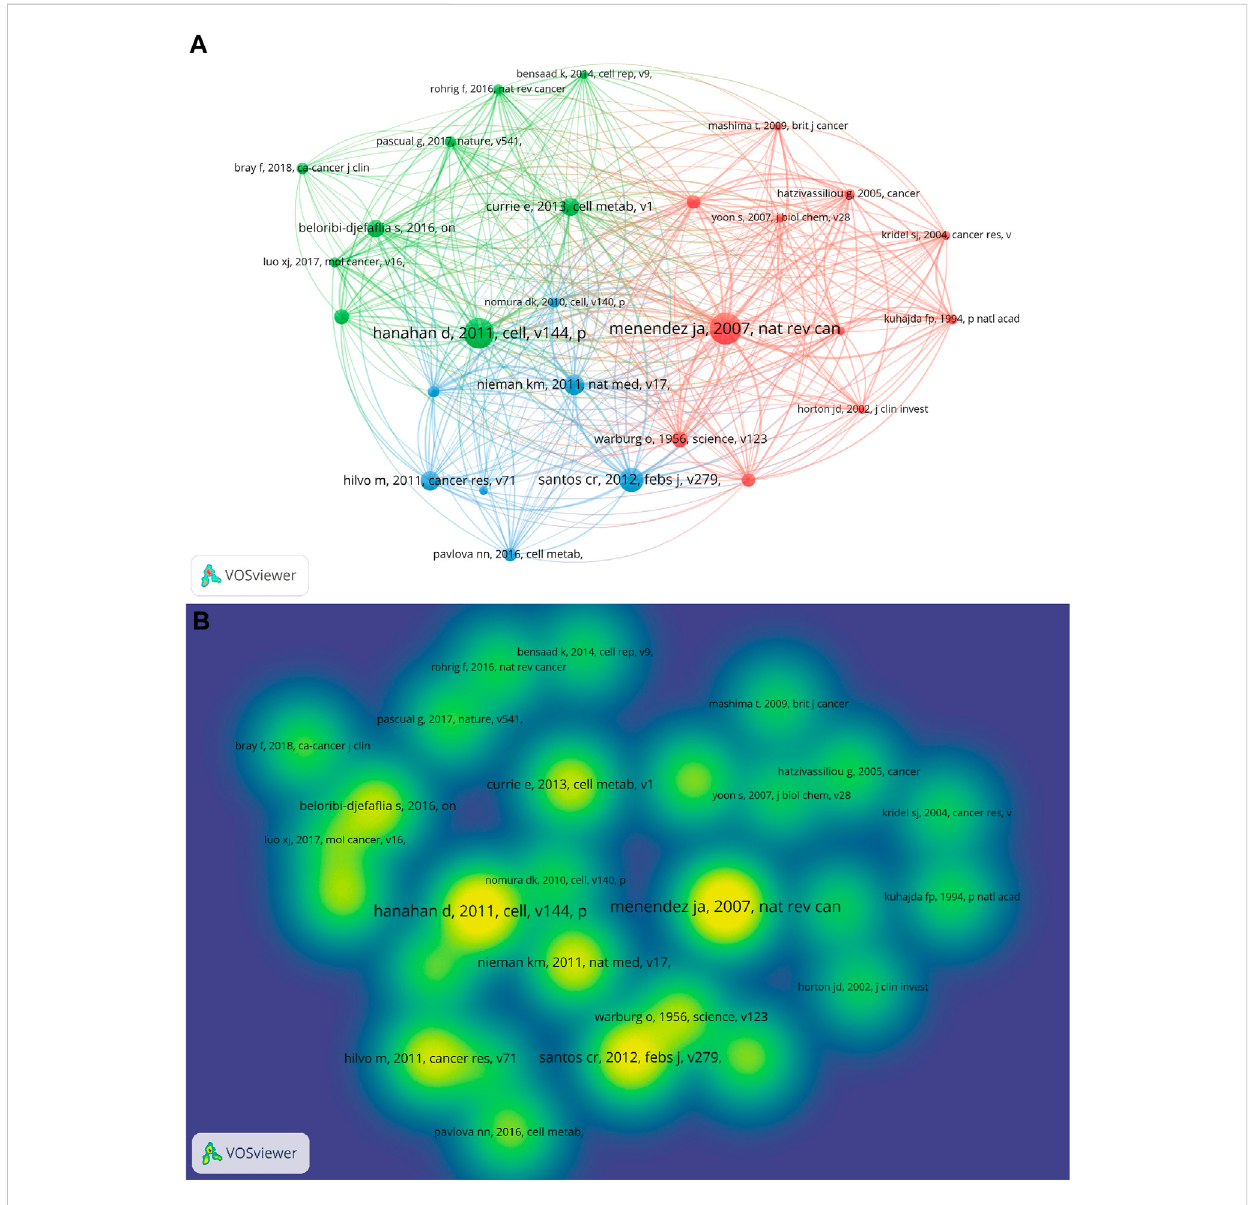
Co-citationnetworkmapanddensitymapofcitedreferences. (A) Co-citationnetworkmapofcitedreferencesofallthepublicationsinthis fi eld. (B) Co-citation density map of cited references of all the publications in this fi